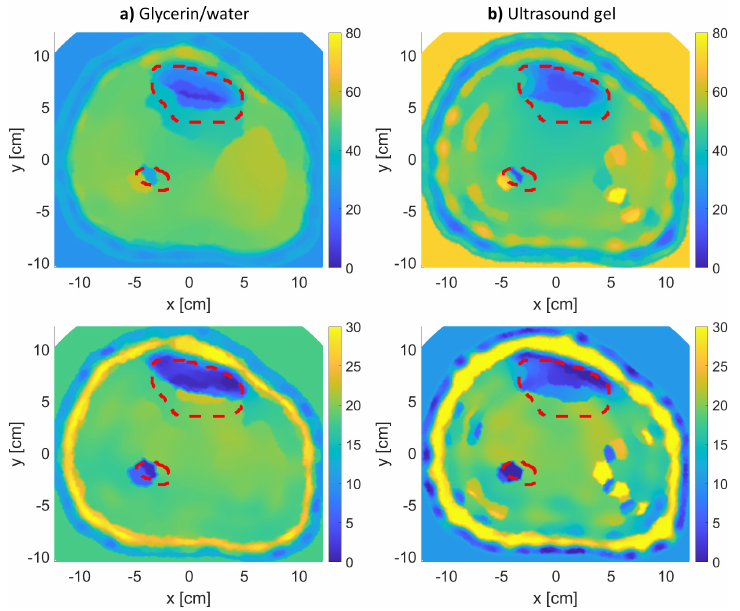
Figure 4. The real ( top row ) and imaginary ( bottom row ) relative complex permittivity results for leg model 1: ( a ) using glycerin/water matching medium, and ( b ) using the ultrasound gel matching medium. The red-dotted lines indicate the bones’ actual